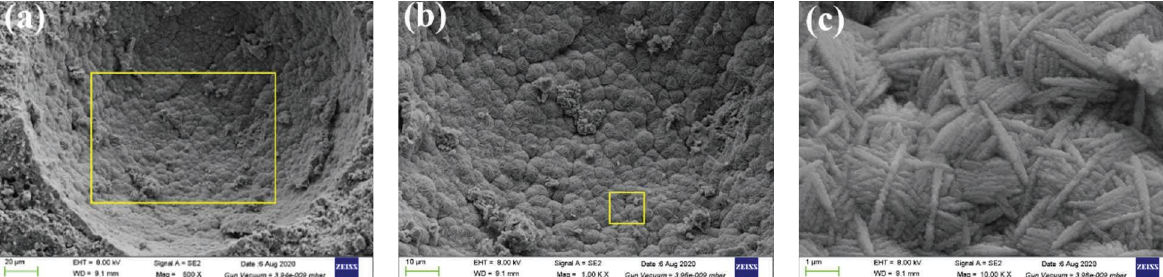
Figure 8: Te SEM images of chabazite in geopolymers matrices with a sodium hydroxide content of 15% after curing at 90 ° C for